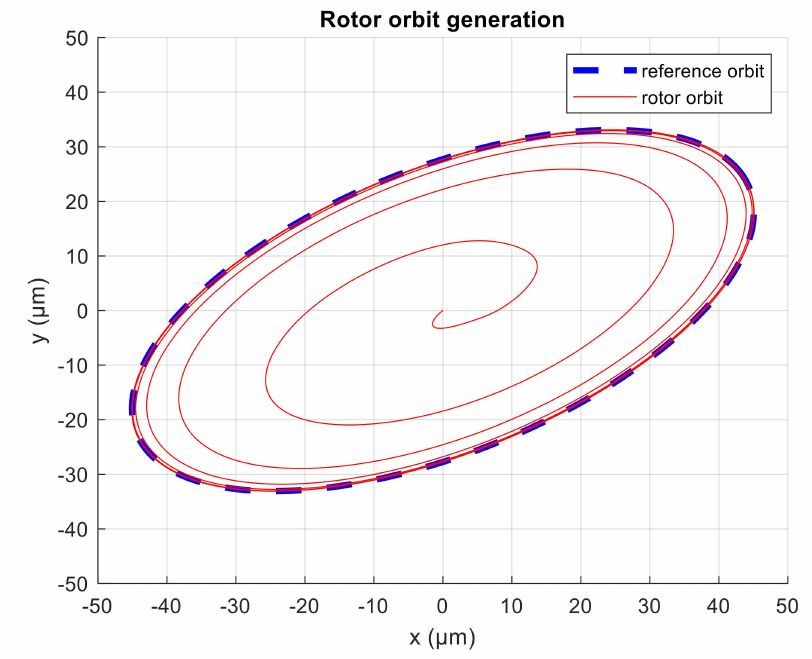
Figure 11. Rotor orbit during